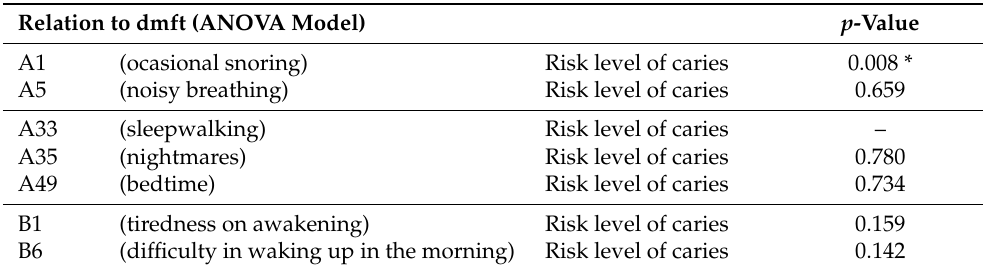
Table 7. Results of the 2-factor ANOVA model: Relationship dmft with each question and caries risk level (Table 7). For question A1, dmft shows a significant relationship with occasional snoring, and this association is also dependent on the patient’s caries risk level ( p =